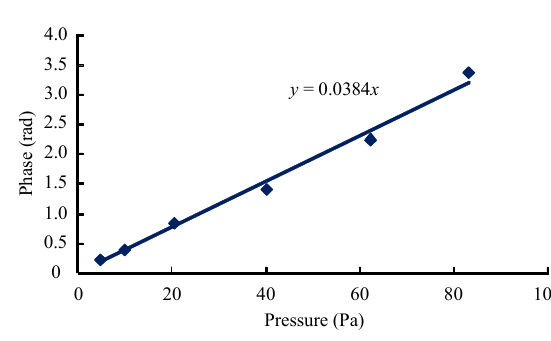
Fig. 4 Signals of DAS sensor and hydrophone. Fig. 5 Phase -pressure relationship.